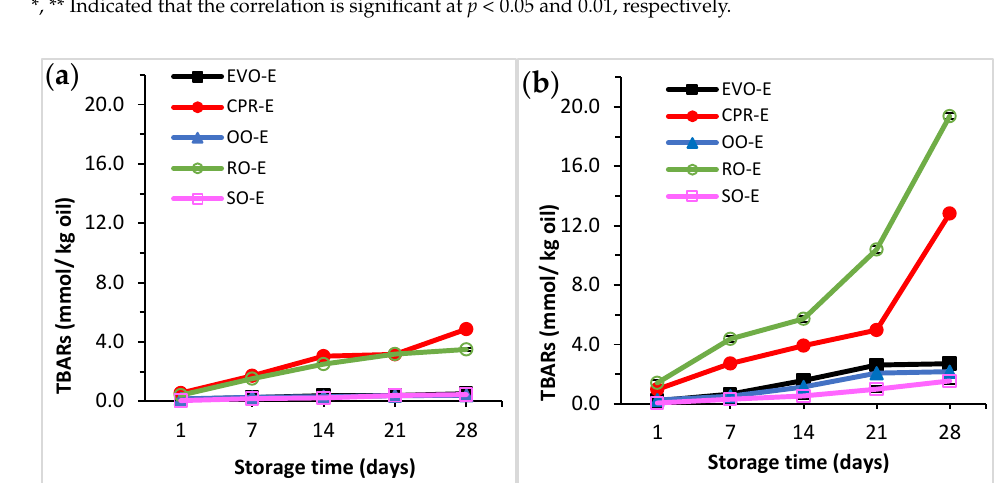
*, ** Indicated that the correlation is significant at p < 0.05 and 0.01, respectively.